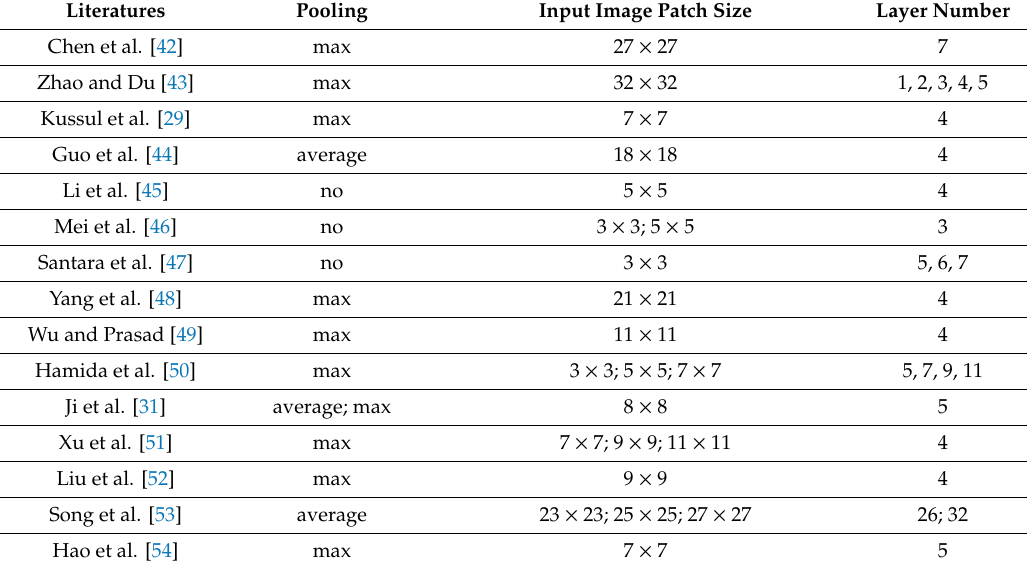
Table 1. Pooling operation, input image patch size and layer number in supervised convolutional neural network (CNN) used in the literature for remote sensing image land cover classification. Only layers with learnable parameters are counted following Simonyan and Zisserman [41] (e.g., pooling operation is not a